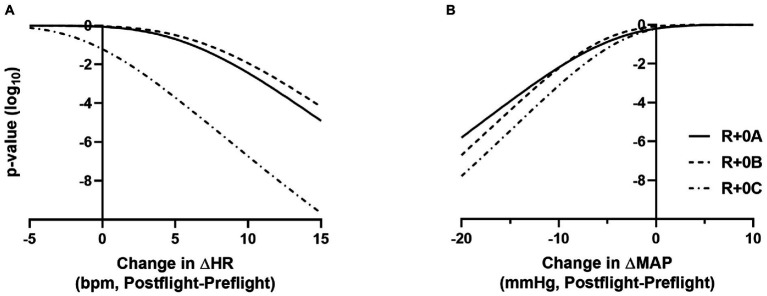

p-value functions (log10 metric) showing how well the data supports the mean preflight to postflight change in ΔHR exceeding N bpm, for −5 < N < 15 (A) and the mean preflight to postflight change in ΔMAP being lower than N mmHg, for −20 < N < +10 (B). Plots are shown for R+0A, R+0B, and R+0C. For example, an actual mean preflight to postflight change in ΔHR exceeding 10 bpm at R+0A is not supported by the data (p < 10−3), and there is very little data support for a mean preflight to postflight change in ΔMAP being less than −15 mmHg at R+0A (p < 10−4).